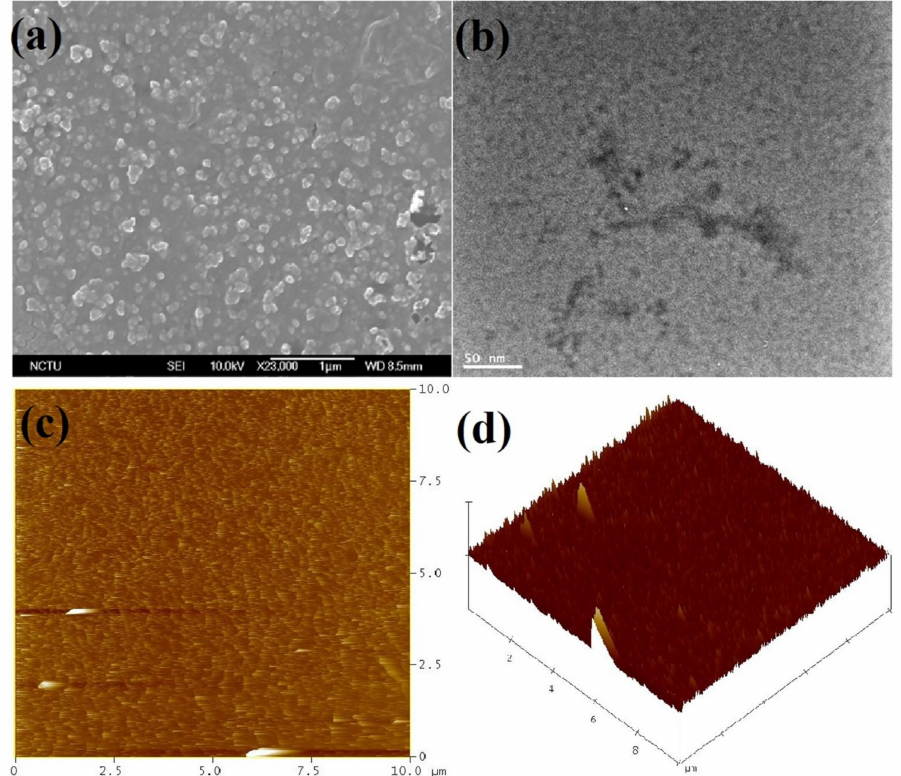
Figure 3. ( a ) Scanning electron microscopy (SEM) image of NDS1 at 100 µ g/mL dispersion (scale: 1 µ m); ( b ) Transmission electron microscopy (TEM) image of NDS1 at 1 ng/mL dispersion (scale: 50 nm); ( c ) Atomic force microscopy (AFM) image of NDS1 at 10 µ g/mL dispersion (scan range: 0–10 µ m) and ( d ) AFM height image of NDS1 at 10 µ g/mL dispersion (scan range: 0–10 µ